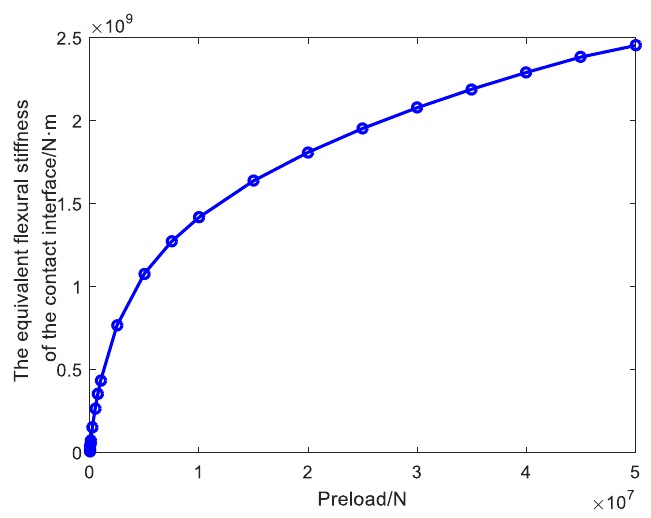
Figure 6. EFS of the contact surface changes with preload.